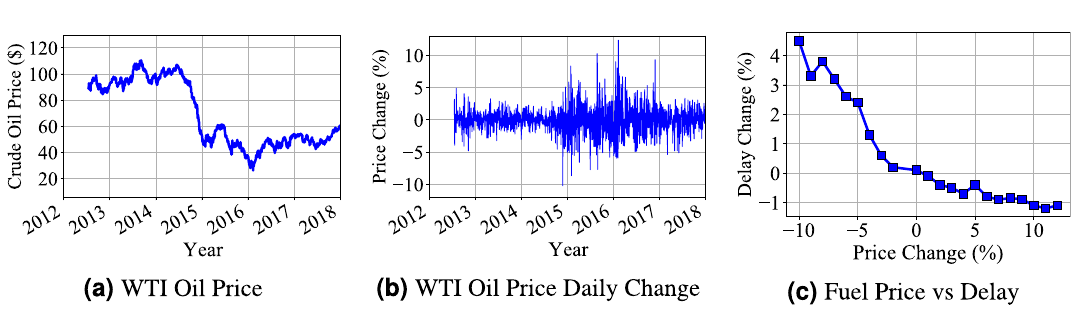
Figure 11. Fuel price change causes the dynamics of delay ratio for above-ground